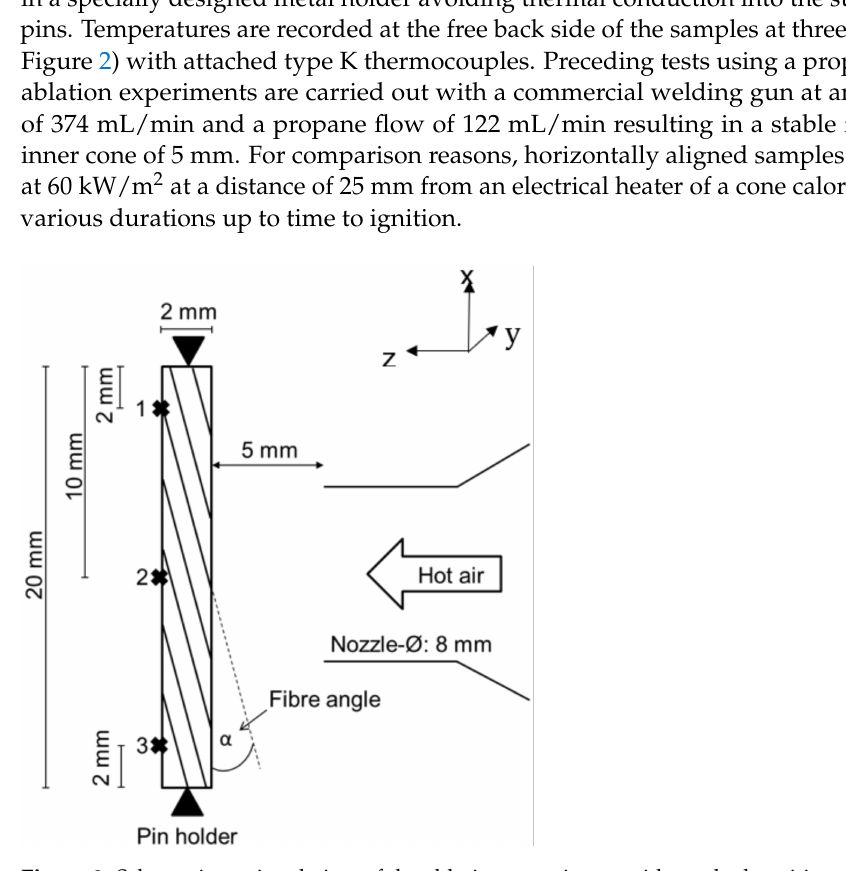
Figure 2. Schematic sectional view of the ablation experiment with marked positions for the attached thermocouples and the subsequent FTIR